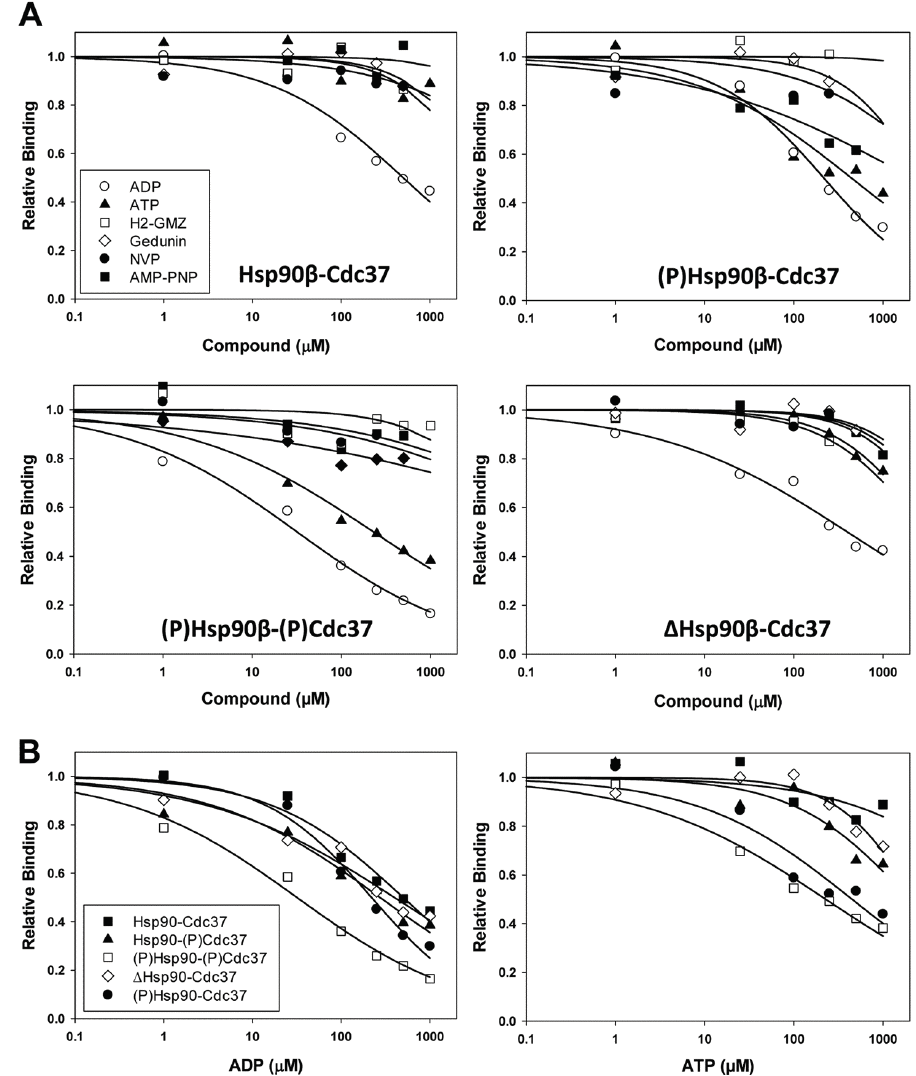
Figure 4. Effect of nucleotides and inhibitors on the Hsp90 β -p50 Cdc37 complex as determined by ELISA. ( A ) Dose-response experiments for the complex formation between immobilized GST-p50 Cdc37 and Hsp90 β (unphosphorylated or phosphorylated) in the presence of ADP,